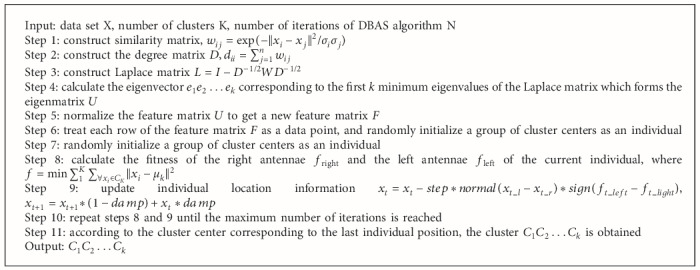
 SC-DBAS algorithm.